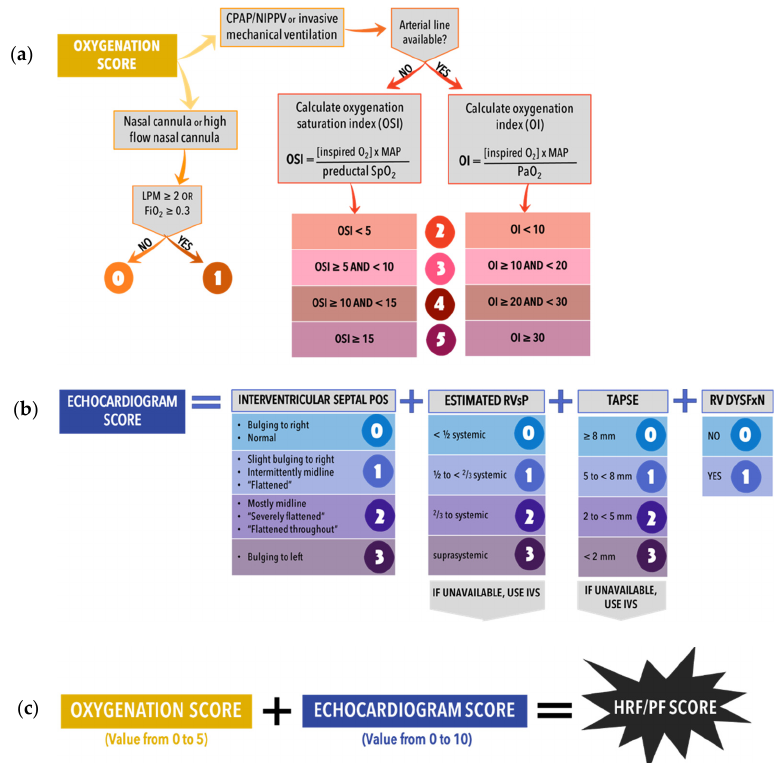
Figure 5. Hypoxic Respiratory Failure and Pulmonary Hypertension Score (HRF/PH). ( a ) Oxygenation component of score. ( b ) Echocardiographic portion of score for PH. ( c ) Total HRF/PH score = Oxygenation score + Echocardiogram Score. CPAP = continuous positive airway pressure, NIPPV = non-invasive positive pressure ventilation, LPM = liters per minute, F i O 2 = fraction of inspired oxygen, OSI = oxygen saturation index, OI = oxygenation index (if both OI and OSI are available, OI will preferentially be used), SpO 2 = pulse oximetry oxygen saturation, MAP = mean airway pressure, P a O 2 = partial pressure of arterial oxygen, RVsP = right ventricular systolic pressure, RV DYSFxN = right ventricular dysfunction, TAPSE = tricuspid annular plane systolic excursion, mm = millimeters. Copyright Avni Bhatt .